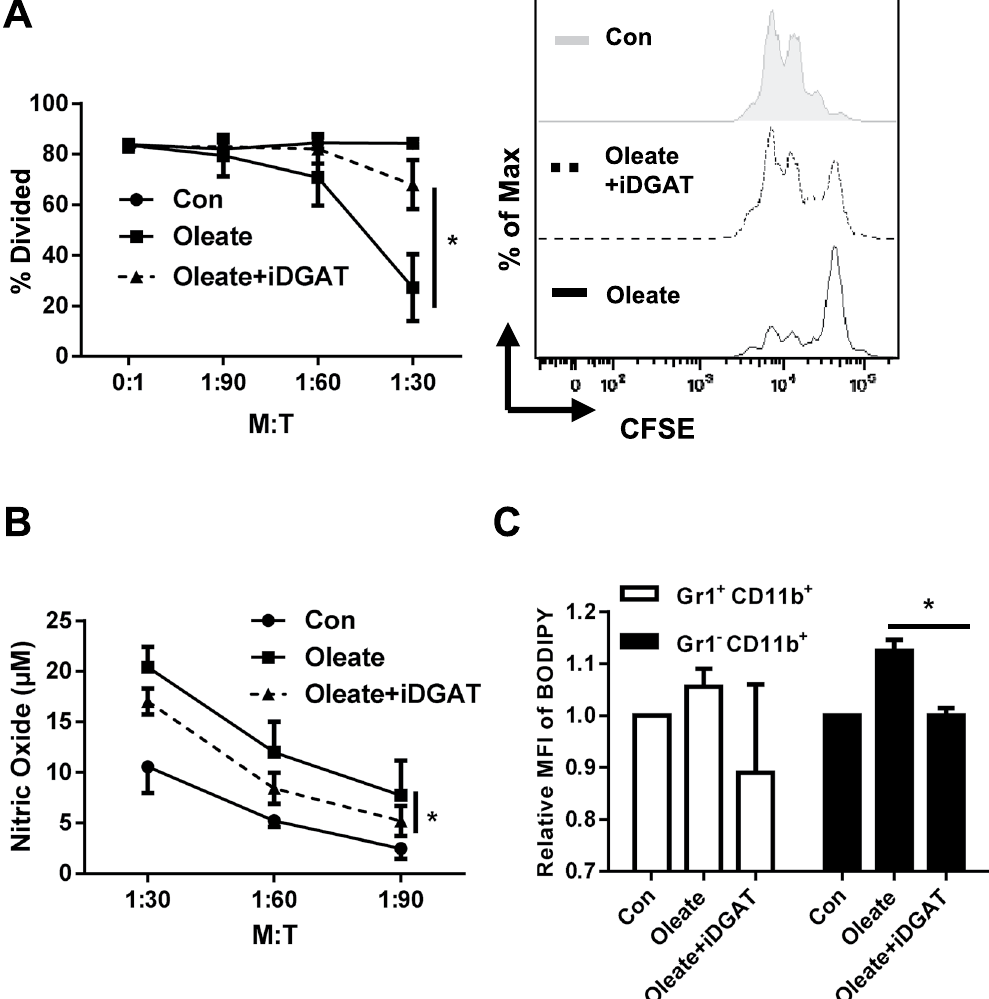
Figure 8. Inhibition of DGAT impedes the impact of sodium oleate on primary cells bone marrow cells. Bone marrow cells were polarized in the presence of 40 ng/ml GM-CSF and treated with the indicated compounds for 7 days. Functional assay was performed via co-culture with purified CD4 + T cell in the ratios indicated ( A ). NO production from the co-culture supernatant was quantified by Griess reaction ( B ). BODIPY staining was used to detect the lipid droplets formation in variant subpopulation of primary bone marrow cells ( C ). Shown is the mean ± SD from two to four independent experiments. * p <